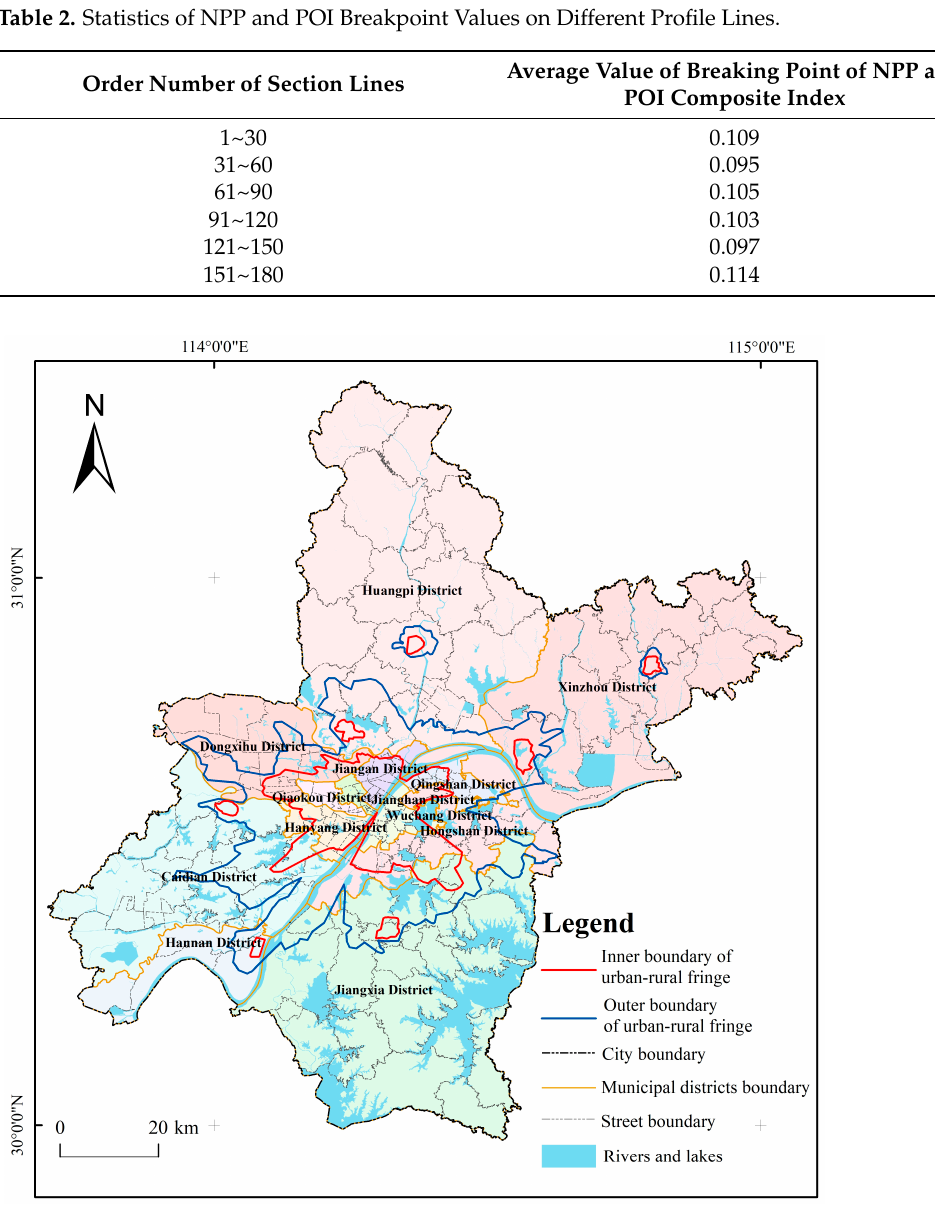
Figure 6. Wuhan urban-rural fringe boundary.